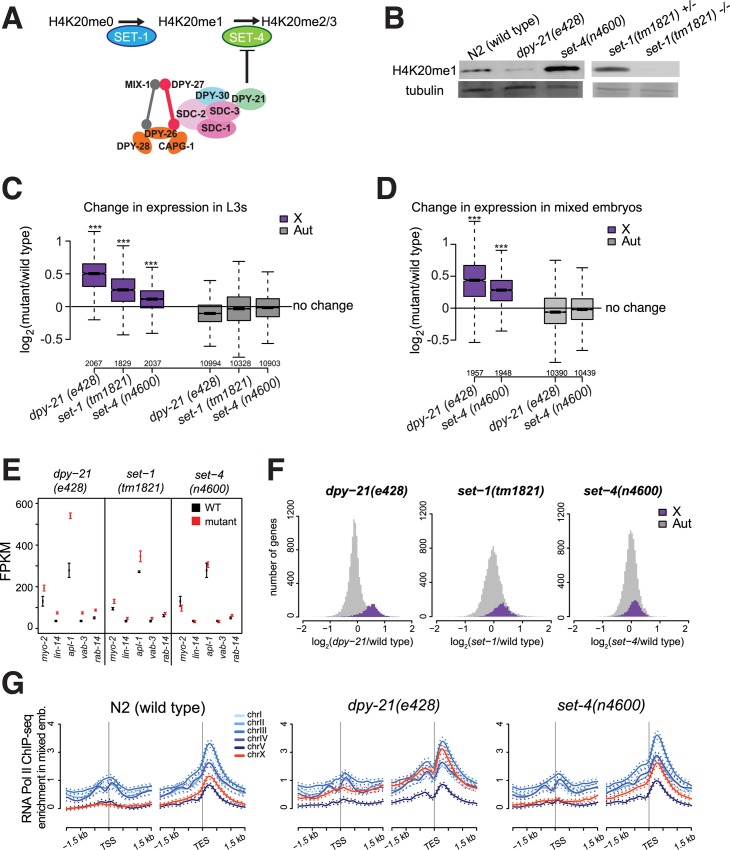
Proper regulation of H4K20 methylation is important for X chromosome dosage compensation.(A) H4K20 methylation is catalyzed in two steps by the histone methyl transferases SET-1 and SET-4. Previous work suggested that the DCC causes H4K20me1 enrichment on the X chromosome by reducing SET-4 catalyzed conversion of H4K20me1 to H4K20me2/3 on the X [18]. (B) Western blot analysis of H4K20me1 levels in wild type N2, set-4(n4600), dpy-21(e428), and in set-1(tm1821) null mutant L3 larvae. (C, D) Distribution of log2 fold-differences in mRNA levels between mutant and wild type worms in (C) L3 larvae and (D)mixed embryos. All three mutations showed a significant difference between X and autosomal expression changes (Wilcoxon rank-sum test, *** = p < 10−3). (E) L3 mRNA-seq differential expression values are plotted for the previously designated dosage compensated genes [11,42,102]. Error bars show the standard error of the mean. (F) The distribution of expression changes (x-axis) in the three mutants show a shift in X chromosome expression, thus the difference between X and autosomes in panel C is not driven by a small number of genes. (G) Average RNA Polymerase II (AMA-1) ChIP-seq enrichment for each chromosome is plotted across the transcription start (TSS) and transcription end sites (TES) in wild type, dpy-21(e428) and set-4(n4600) mixed stage embryos.